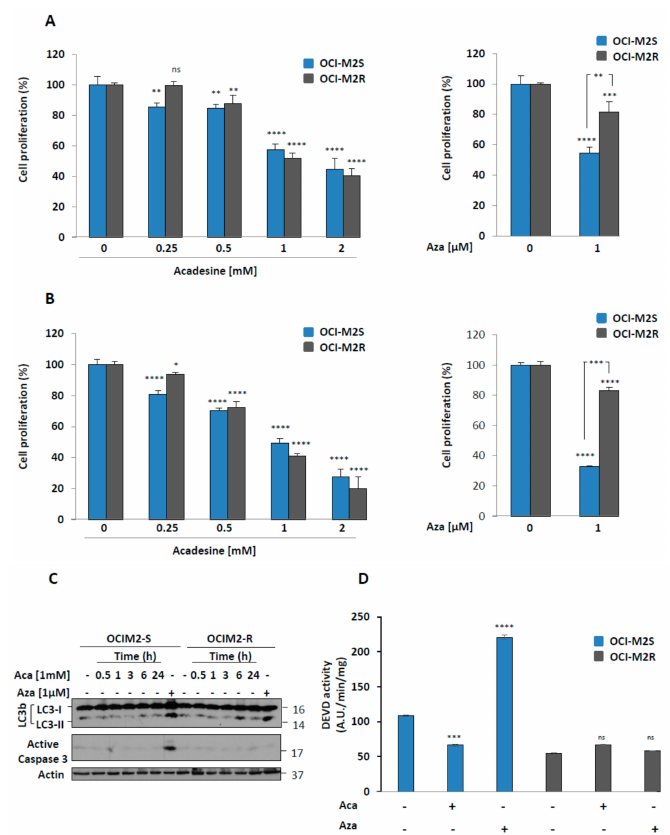
Figure 1. Aca exerts anti-leukemic e ff ects on both OCI-M2S and OCI-M2R cell lines ( A ) Left